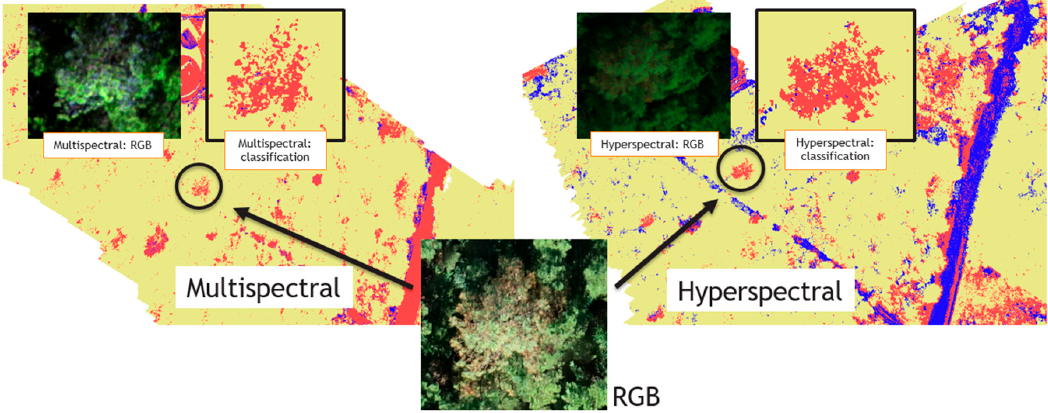
Figure 11. Classification maps—zoomed in. The symptomatic tree is successfully spotted in both multi- and hyperspectral data. Color code of classified pixels: blue = infected, red = suspicious, yellow = healthy.